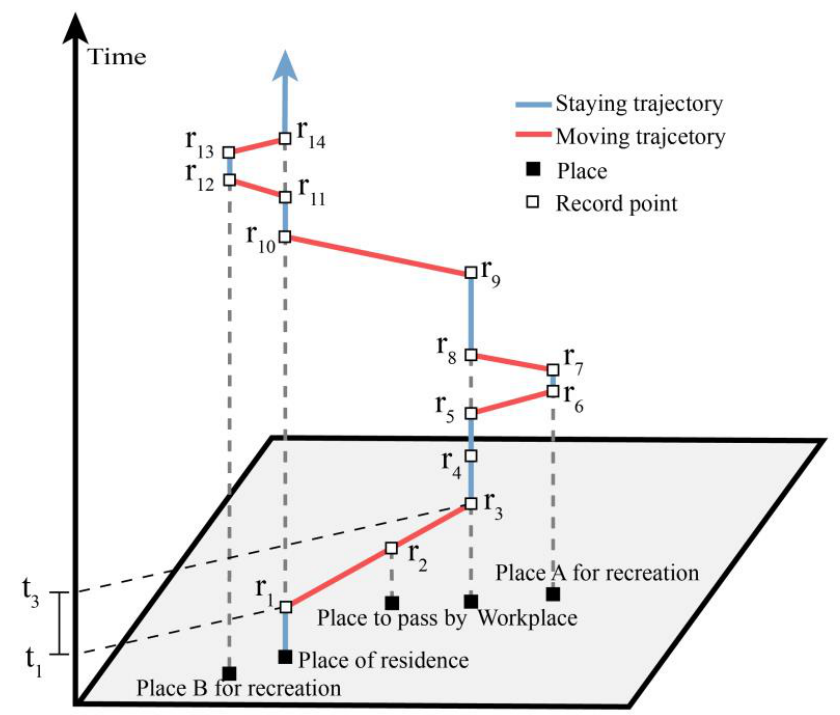
Figure 3. Typical daily spatial–temporal trajectory of a commuter.